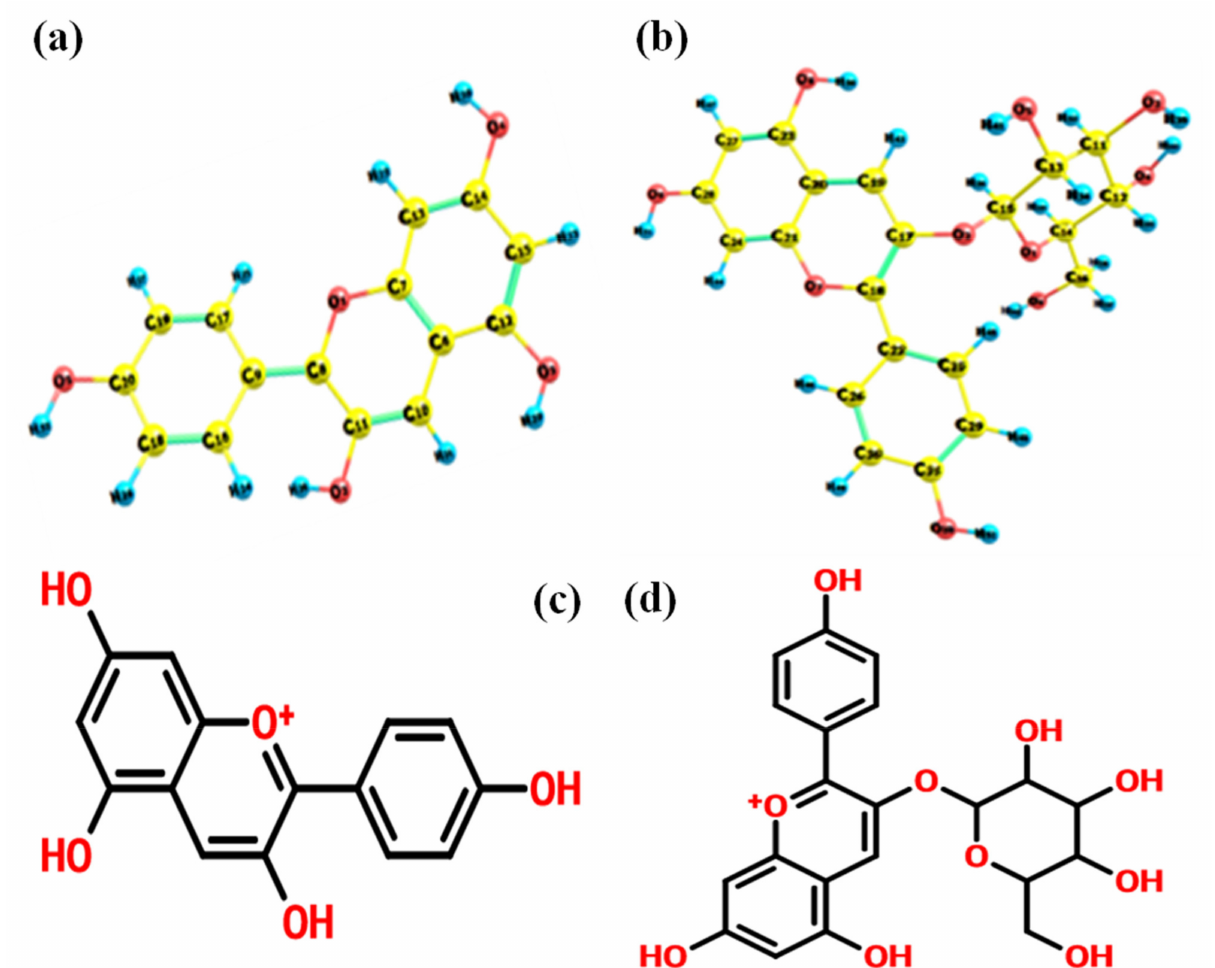
Figure 1. Optimized conformers of ( a ) pelargonidin, ( b ) pelargonidin-3-O-glucoside, ( c ) pelargonidin 2D conformer and ( d ) pelargonidin-3-O-glucoside 2D